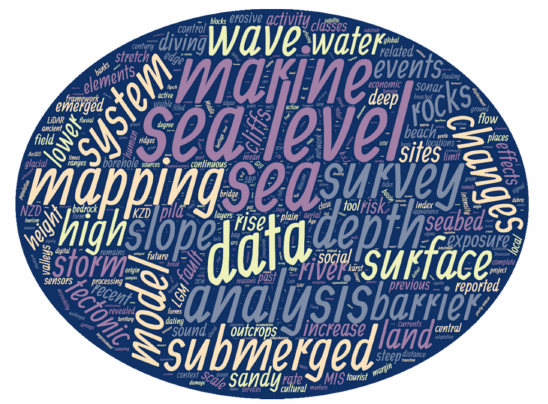
Figure 1. Word cloud of the Special Issue “Landscapes and Landforms of Terrestrial and Marine Areas” providing a visual representation of the most recurrent words in the full texts of the 14 articles published in the volume. Keywords and focal issues for further investigations on the land-and-sea interface appear to be sea level, submerged features, data, mapping, modeling, waves, changes, systems, and so